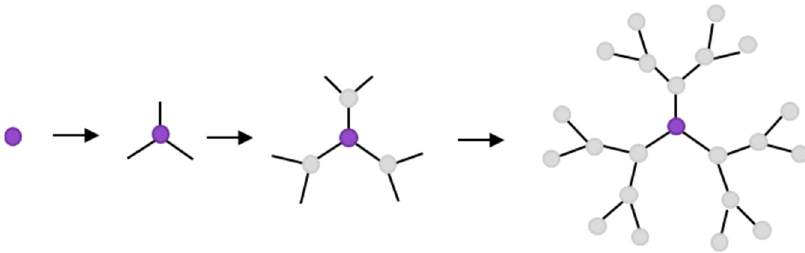
Figure 3. The divergent method of dendrimer synthesis.